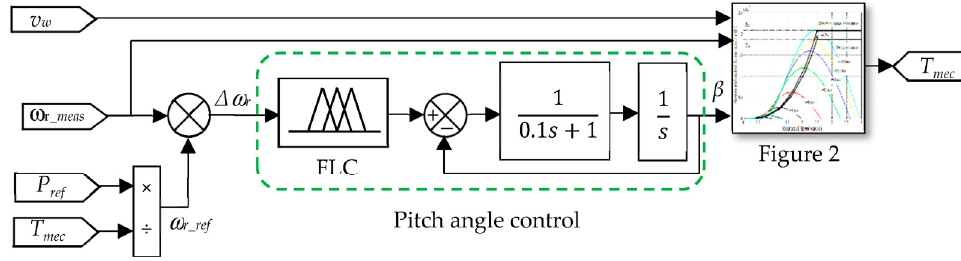
Figure 8. The proposed modeling of de-loaded-technique-based FLC to regulate the pitch angle and the mechanical torque.